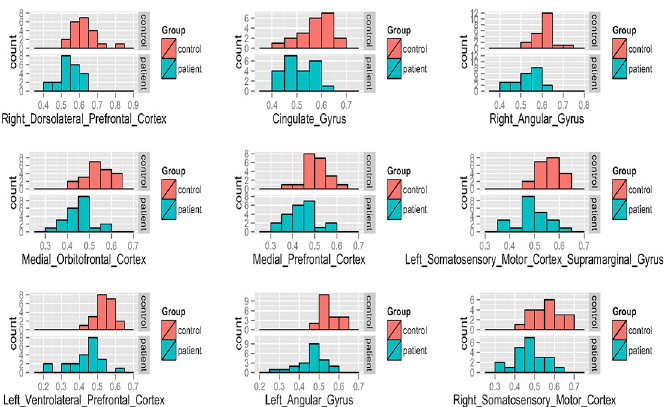
Fig 2. GM volume details of ROI where Controls > Patients. Nine panels which correspond to the clusters of Control > Patient GM volume demonstrated with whole-brain analyses. Each panel displays two histograms, salmon color bars indicating controls and teal color bars indicating patients. For all histograms, the x-axis represents GM volume (intensities mapping GM volume in mL) and the y-axis represents number of